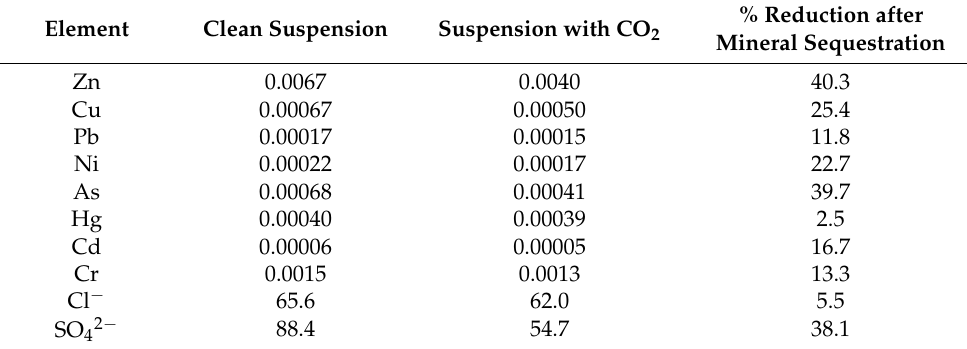
Table 5. The effect of the mineral sequestration process on pollutant leachability from aqueous suspensions of FBC fly ash, mg/dm 3